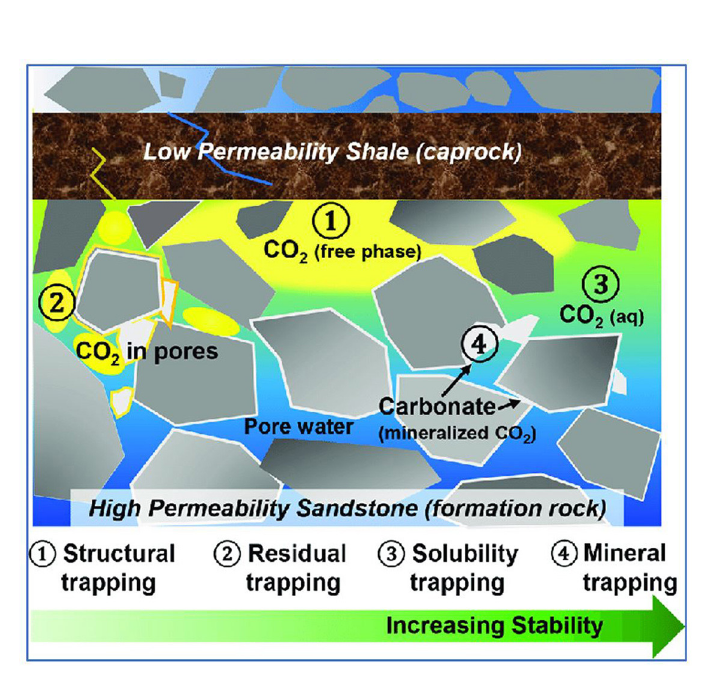
Fig. 13. – CO 2 trapping mechanisms